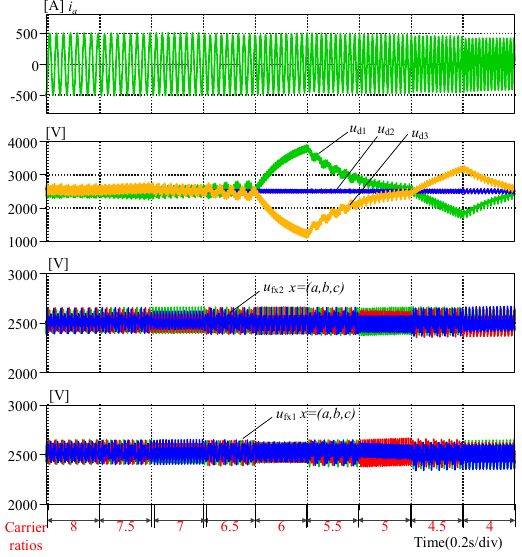
Figure 8. The circuit states of 5L-HC under different C r. Table 4. The simulation parameters for